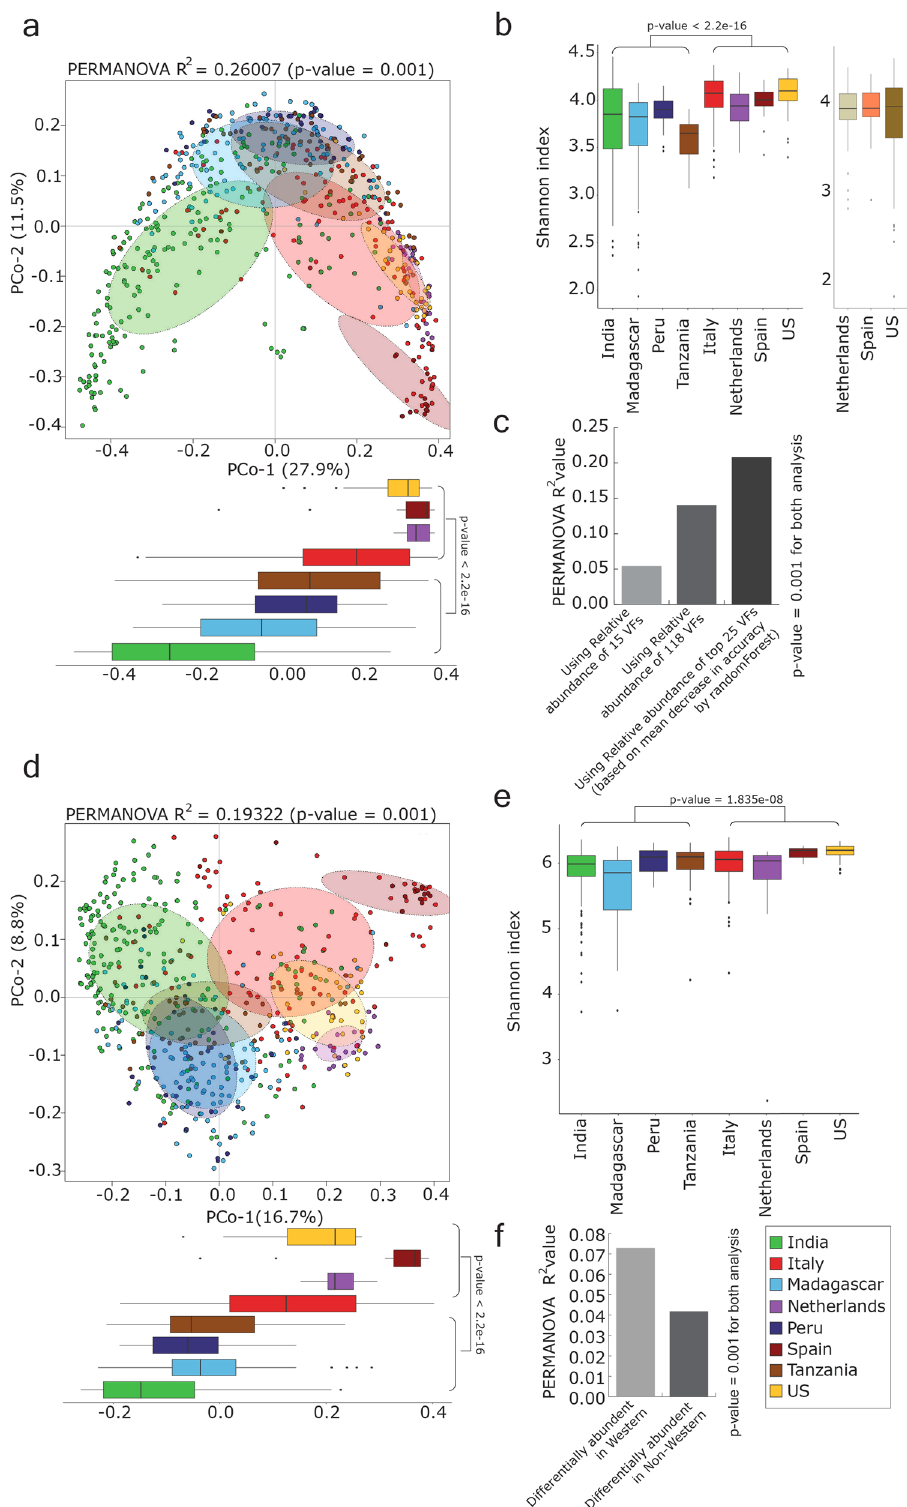
(full-data set) in each population showed that western populations contained a signi fi cantly higher number of these genes and Shannon diversity index compared to non-western populations (Fig. 7b and Supplementary Fig. 22a). The above observations were con fi rmed by analyzing the core virulence factor